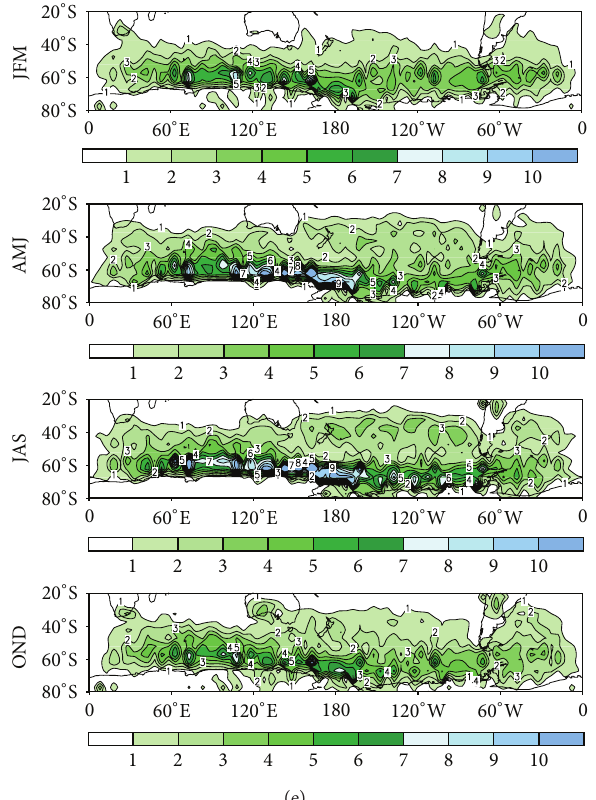
Figure 9: Southern Hemisphere seasonal cyclone track frequency climatology for (a) NCEP1 5801, (b) ERA40 5801, (c) NCEP2 7910, (d) NCEP1 7910, and (e) NCEP1